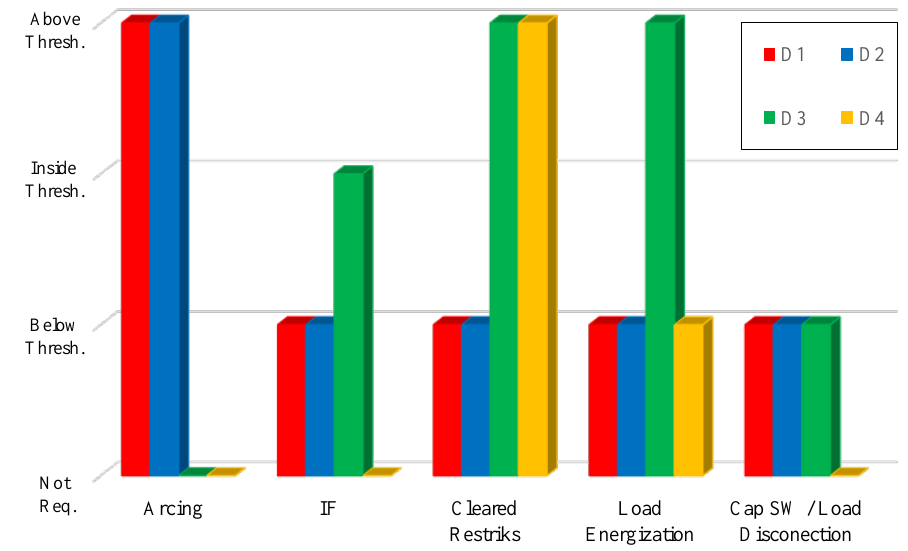
Figure 13. All Events in relation to DT inputs and their values to their respective thresholds. Table 4. The required values for all DT inputs with SCADA communication to identify the issue.